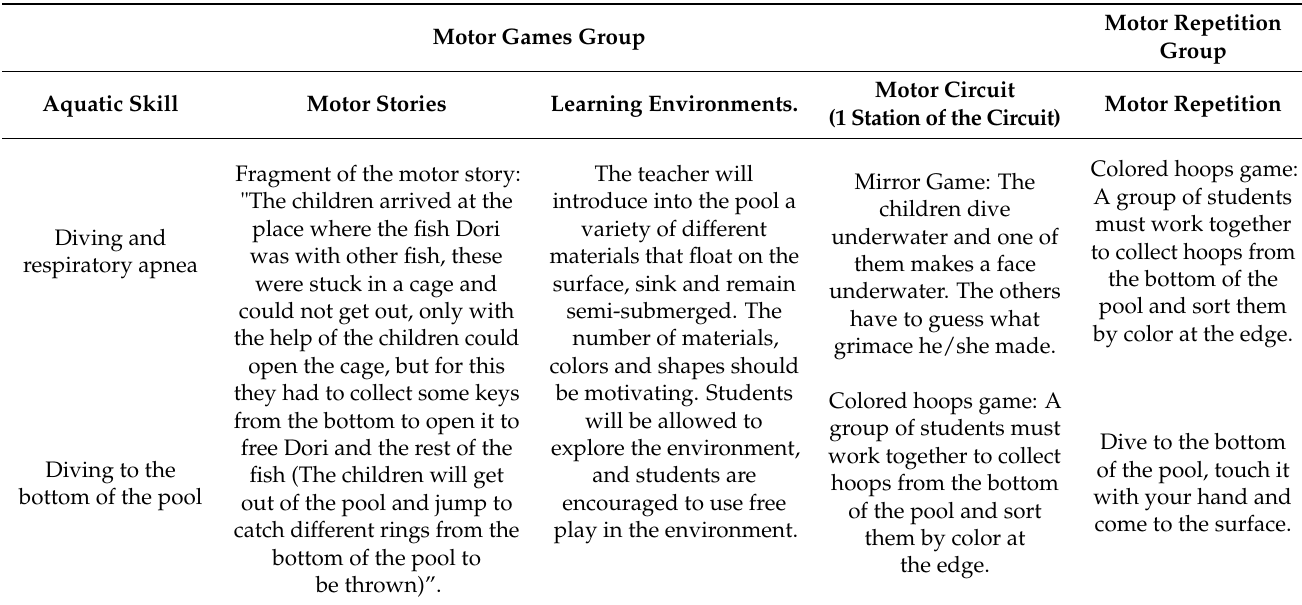
Table 1. Example of the development of the different activities. Motor Games